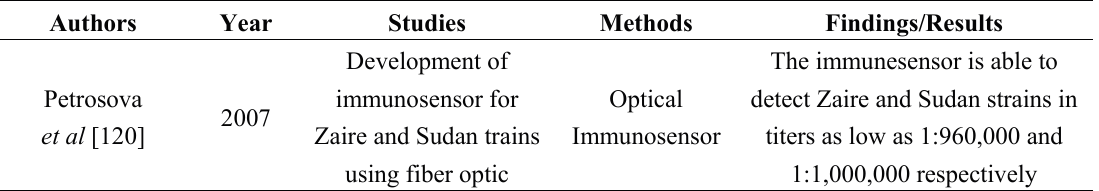
Table 9. Summary of the biomedical engineering technique in Ebola